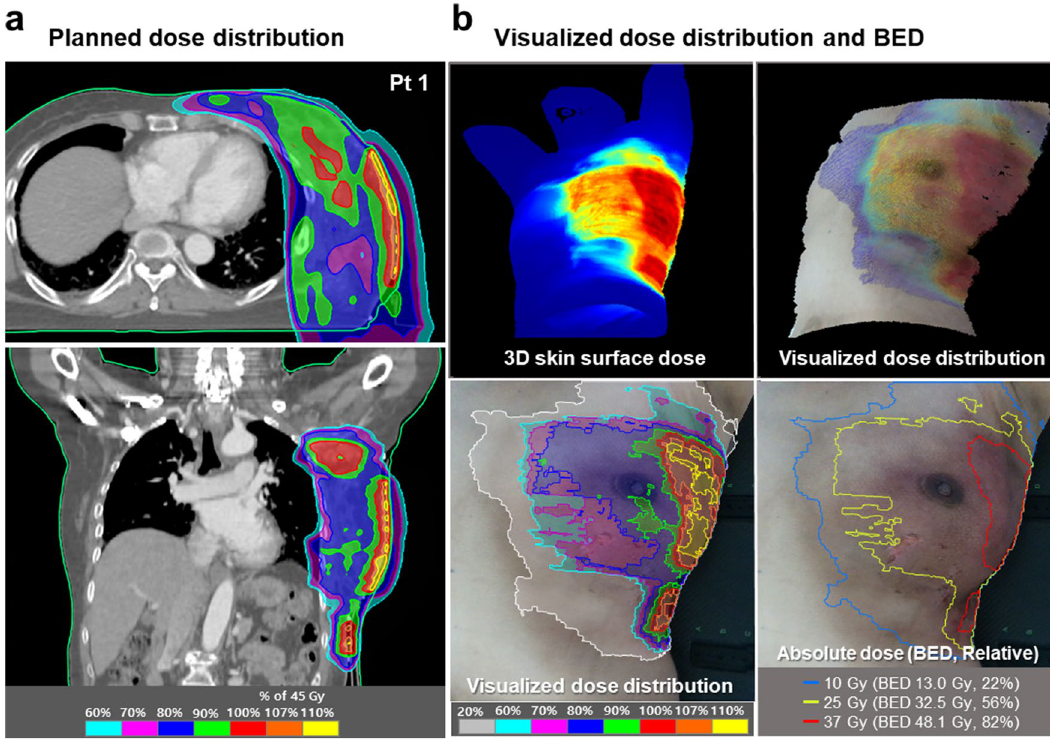
Figure 2. Representative example of a dose image projected onto the patient`s skin (with different dose indices). ( a ) Planned dose distribution in the transversal (top) and coronal (bottom) views from the treatment planning system (TPS) for Patient 1. ( b ) Radiation dose-toxicity evaluation system (RaTES) visualizes the dose distribution at the skin surface in three-dimensional space (top). The physical dose distribution is converted to absolute dose, biologically effective dose (BED), and relative dose. The erythema and moist desquamation are consistent with the pattern of the dose distribution map above the 10 Gy and 37 Gy absolute dose